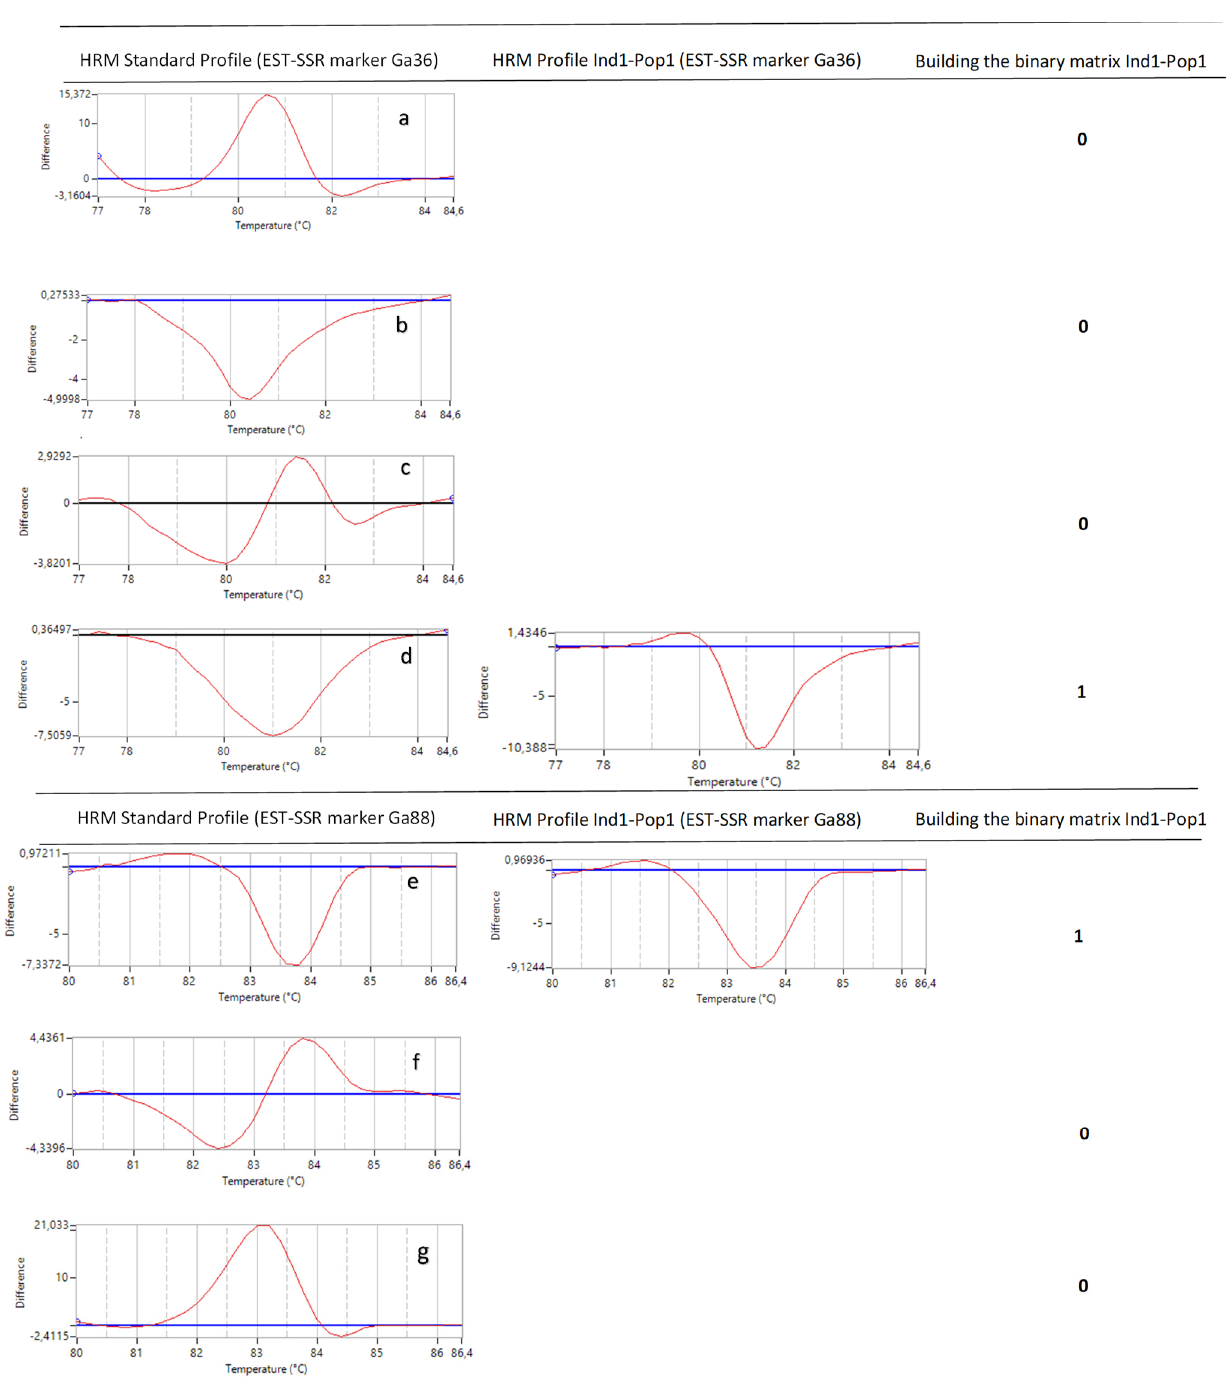
Figure 14. Scheme to building the binary matrix. The profiles on the left show HRM standard profile (reference profile) of genotypes of G. avellana Mol. analyzed using two EST-SSR markers (Ga36 and Ga88) . ( a ) Genotype G. avellana code 5R01, ( b ) Genotype G. avellana code 19RS01, ( c ) Genotype G. avellana code 8L01, ( d ) Genotype G. avellana code 43C01, ( e ) Genotype G. avellana code 38P01, ( f ) Genotype G. avellana code 27A02, and ( g ) Genotype G. avellana code 21C02. The center image shows the profile obtained for one individual (Ind1) of one population (Pop1). The image on the right shows the transformation to 0 and